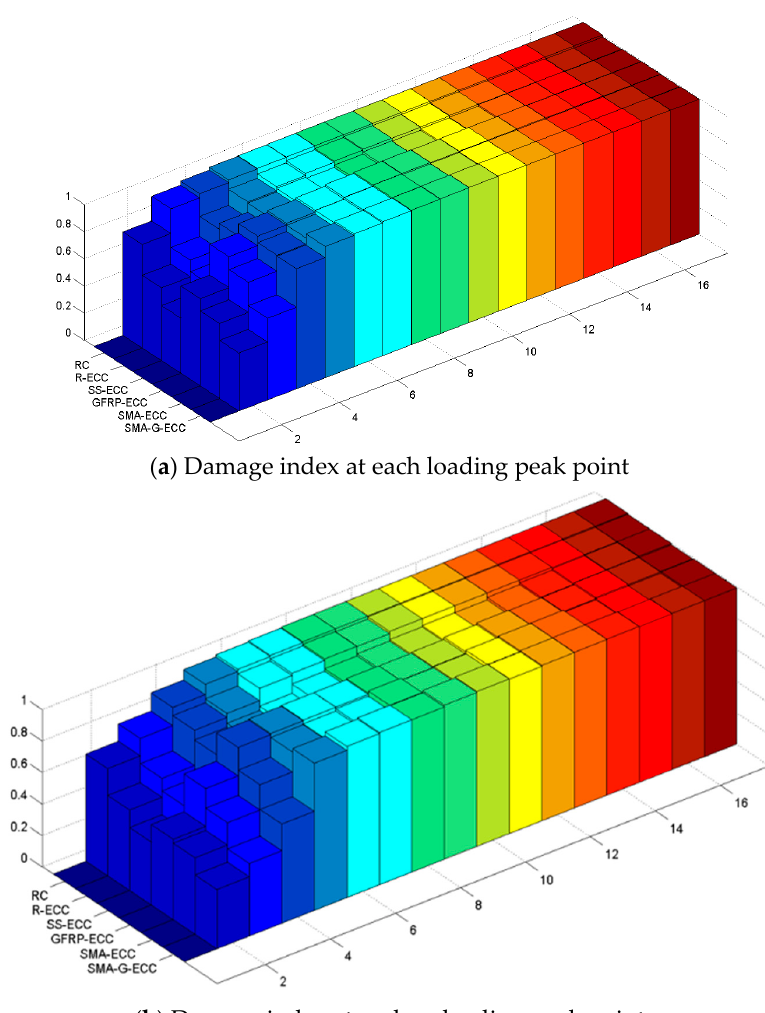
Figure 14. Damage index.